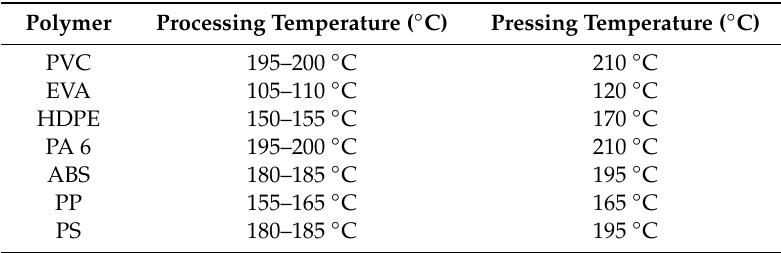
Table 2. Processing temperatures for each material with the Brabender mixing machine and pressing temperatures at constant pressure at 200